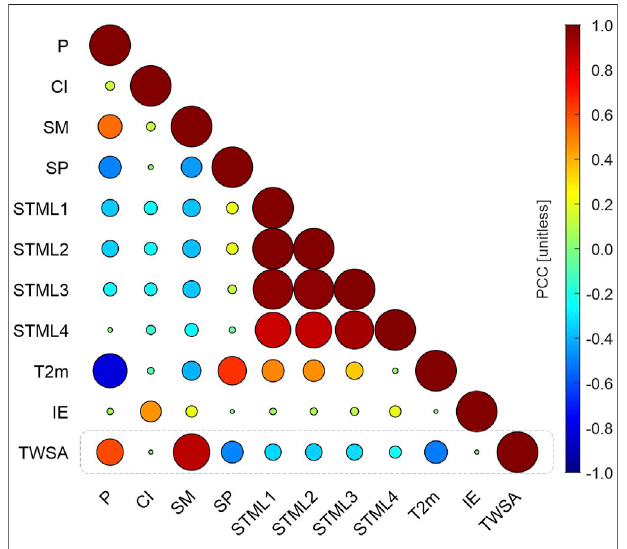
Frontiers in Environmental Science |